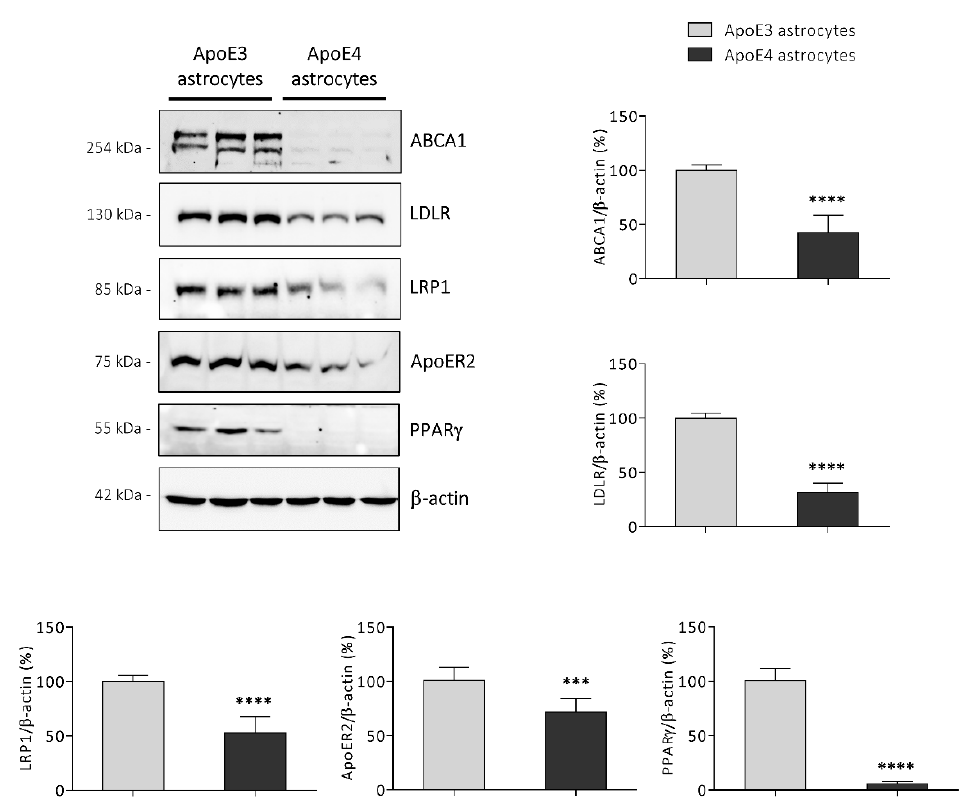
Figure 5. Analysis of the levels of key proteins involved in lipid homeostasis. The protein levels of the ATP binding cassette subfamily A member 1 (ABCA1), ApoE receptor 2 (ApoER2), low-density lipoprotein receptor (LDLR), LDLR-related protein 1 (LRP1), and peroxisome proliferator activated receptor γ (PPAR γ ) were determined by Western blotting in ApoE3 and ApoE4 immortalized mouse astrocytes. Data were normalized to the corresponding β -actin levels and are shown as percentage of average ApoE3 values. Data are expressed as mean values ± SD of three different experiments ( n = 9 , Student’s t -test). **** p < 0.0001 and *** p < 0.001 vs. ApoE3 astrocytes.